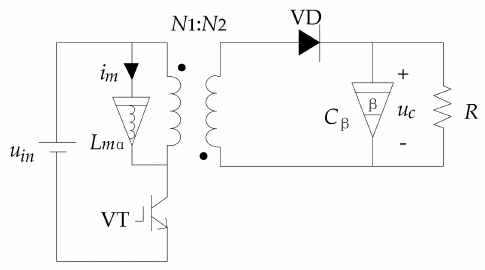
Figure 2. The circuit model of the fractional-order flyback